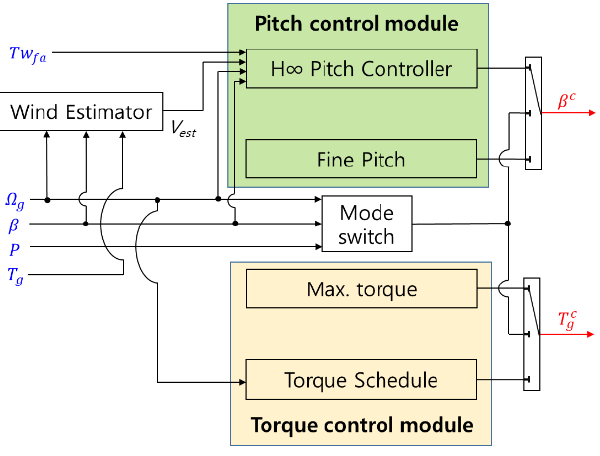
Figure 6. Block diagram of the pitch H-infinity control algorithm.